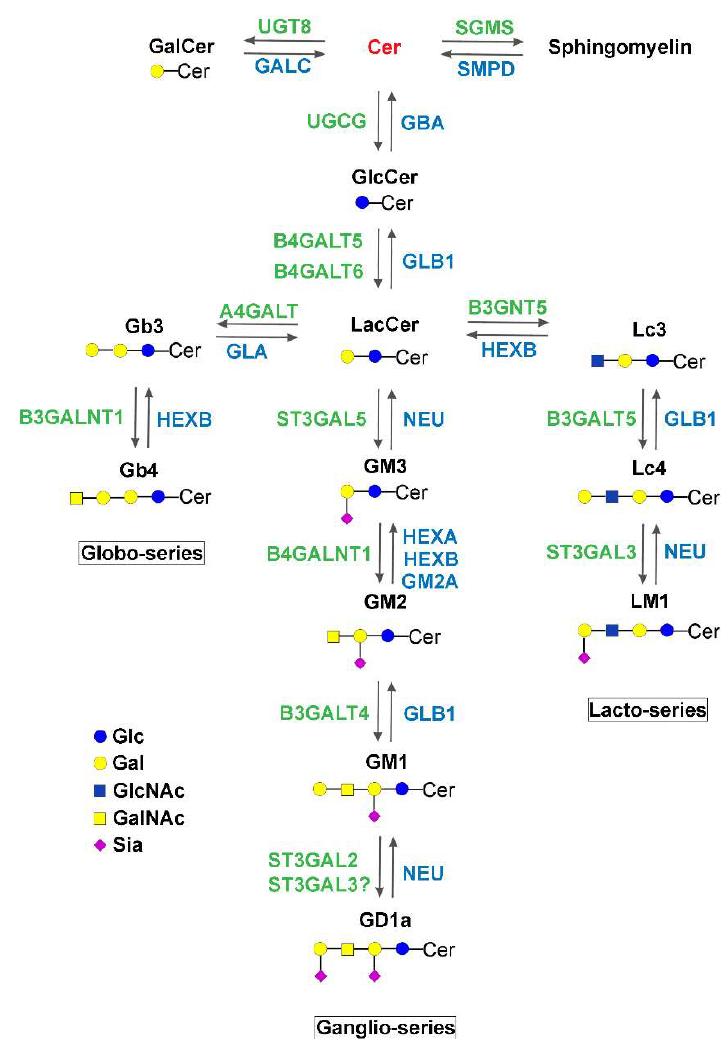
Figure 2. Biosynthesis and degradation of complex glycosphingolipids. Monosaccharides are depicted according to the current representation: Glc, glucose; Gal, galactose; GlcNAc, N-acetylglucosamine; GalNAc, N-acetylgalactosamine; Sia, sialic acid. Enzyme symbols are according to the